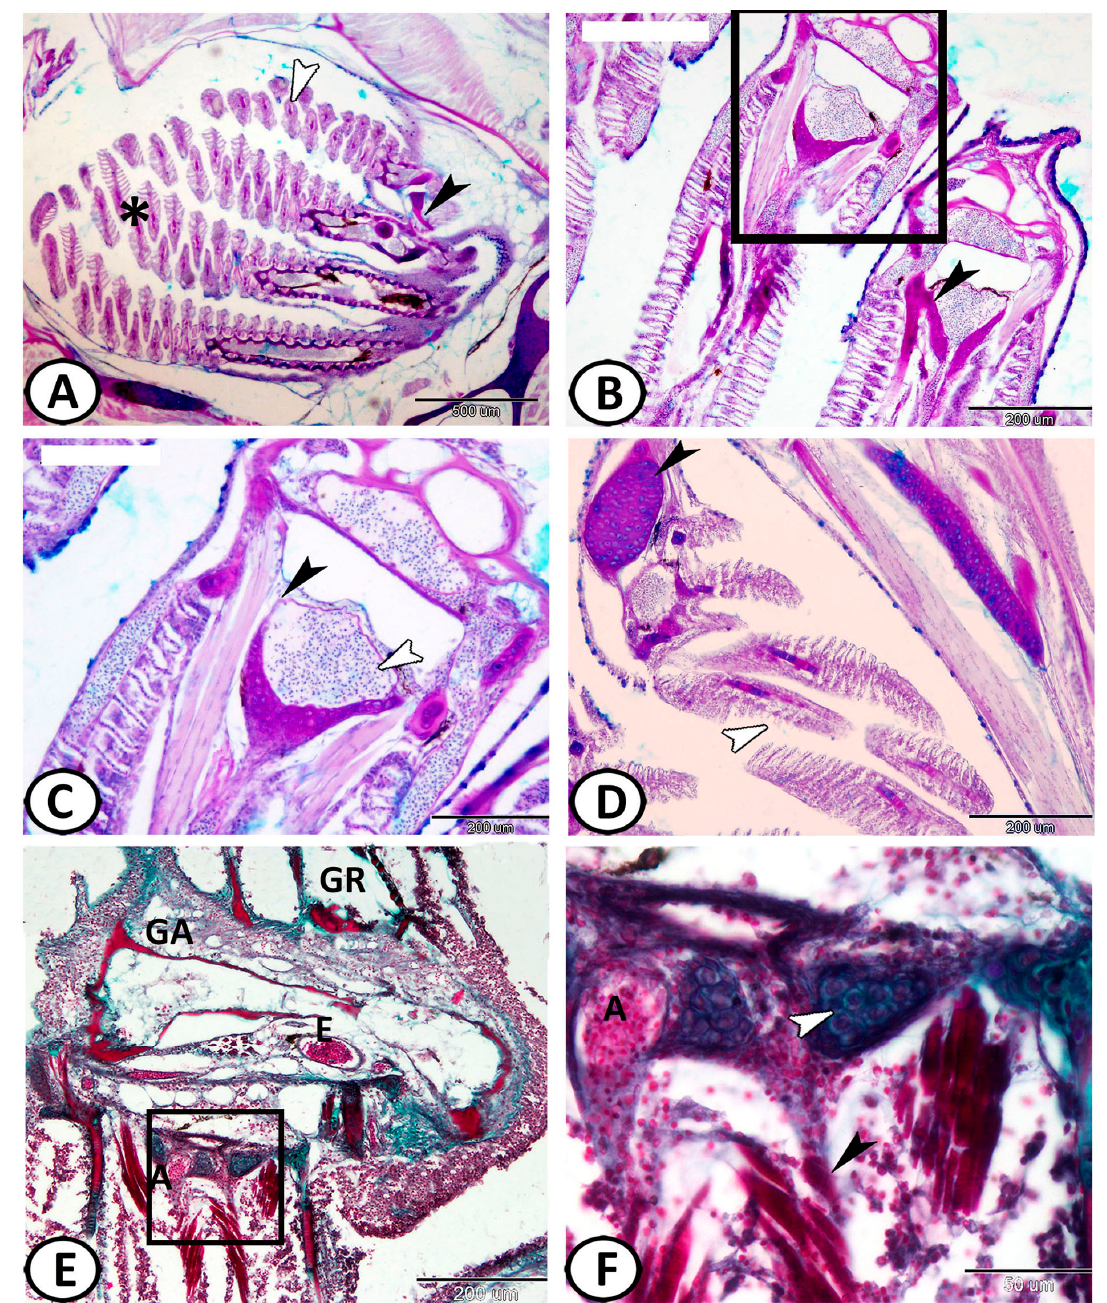
Figure 1. The general structure of the gills of molly fi sh by light microscopy. ( A , B ) The gills of molly fi sh consisted of four holobranchs (white arrowhead) that extend from the fl oor to the roof of the buccal cavity with four pairs of cartilaginous gill arches (black arrowheads), onto which two rows of gill fi laments (asterisk) are a tt ached. (PAS-AB/HX). ( C ) Higher magni fi cation of the boxed area in Figure B shows the gill arch (black arrowhead) and a ff erent blood vessels (white arrowhead). ( D ) Gills stained by PAS-AB/HX showing gill fi laments (white arrowhead) radiating from the gill arch (black arrowhead). ( E ) The gill rakers (GR) are bony projections, which point forward and inward from the gill (or branchial) arch (GA). Note the a ff erent ( A ) and e ff erent ( E ) blood vessels (Crossmon’s trichrome). ( F ) Higher magni fi cation of the gill arch shows cartilaginous supports (white arrowheads) and branchial muscles (black arrowheads). Note the a ff erent ( A ) blood vessels.